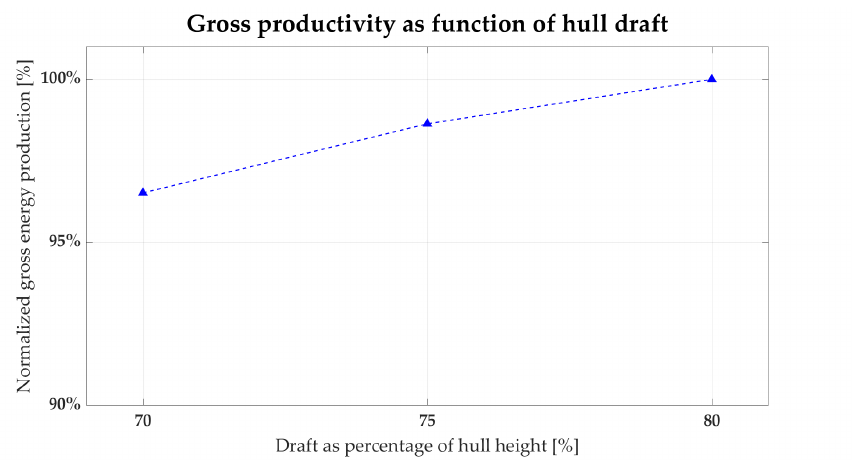
Figure 12. Gross productivity as function of hull